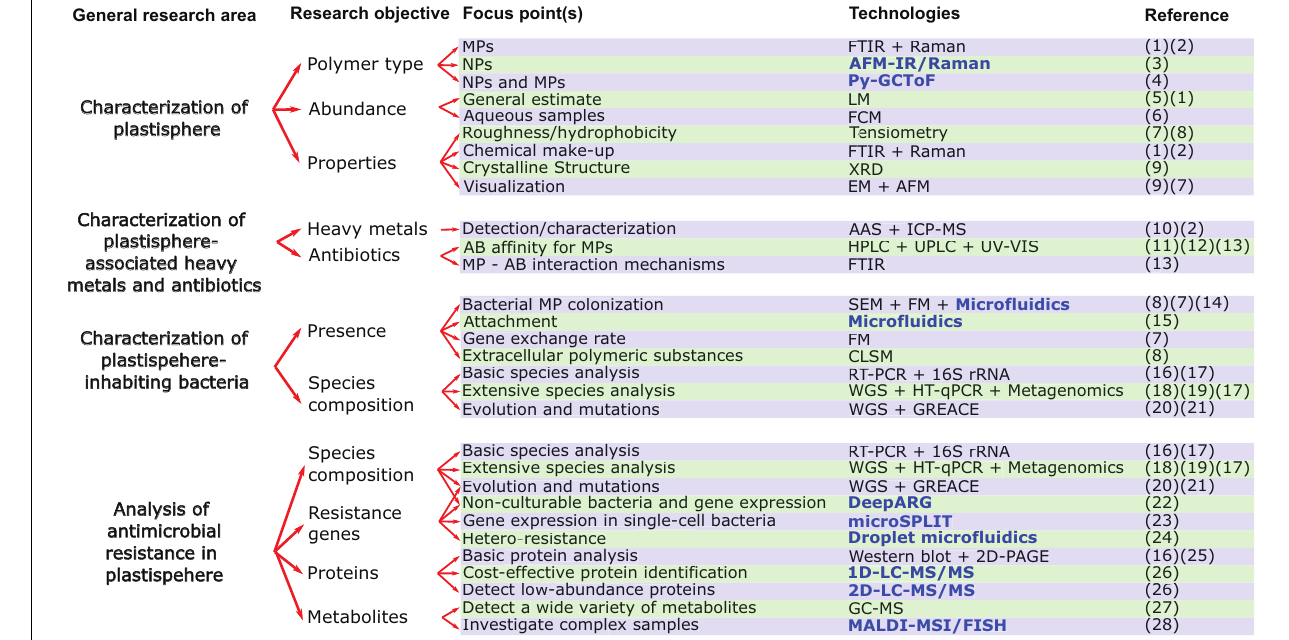
FIGURE 2 | Flow chart with current and novel (written in bold and blue color) approaches for studying the effects of plastisphere-associated pollutants (heavy metals, antibiotics) on antimicrobial resistance. Abbreviations for technologies in alphabetical order: AAS, Atomic absorption spectroscopy; AFM, Atomic